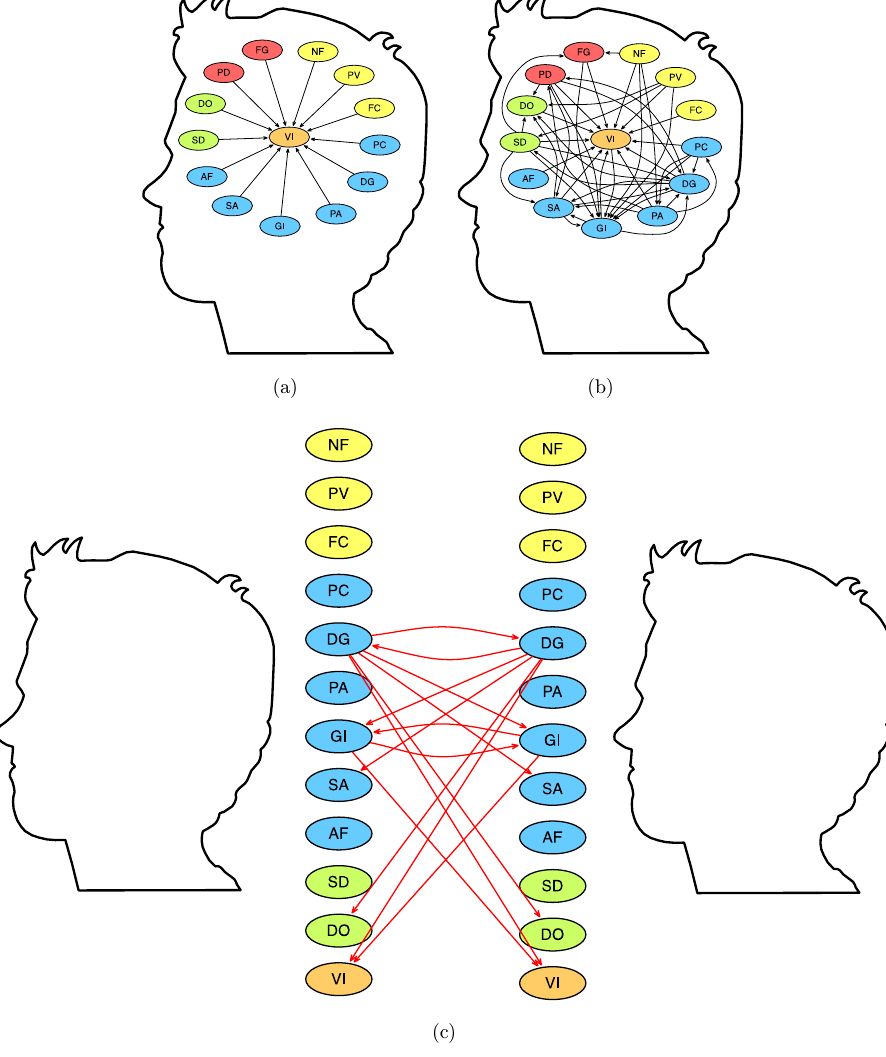
Fig. 2. (a) Factor model of the 11 intrinsic factors and 2 extrinsic factors linked to youth violence, without interdependencies between factors. (b) Complex network model of the 11 intrinsic factors and 2 extrinsic factors linked to youth violence, including interdependency links between factors. In this ¯gure, familial factors are colored yellow, individual factors are colored blue, school factors are colored green, peer factors are colored red, and youth violence (VI) is colored orange. (c) Unpacking the peer interactions between intrinsic factors of two individuals. In (b), we ¯nd arrows from PD to DG, GI, SA, DO, and VI, and an arrow pointing from DG to PD. This means that DG of agent j in°uences DG, GI, SA, DO, and VI of agent i , while DG of agent i in°uences DG of agent j . Similarly, in (b), we ¯nd arrows from FG to GI and VI. This means that GI of agent j in°uences GI and VI of agent i